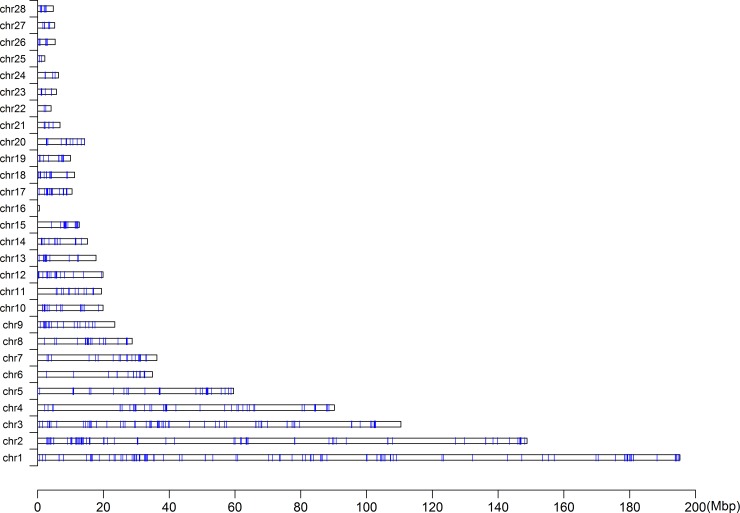
The genome-wide map of selective signature.The blue vertical line represented the selective signature across the genome.